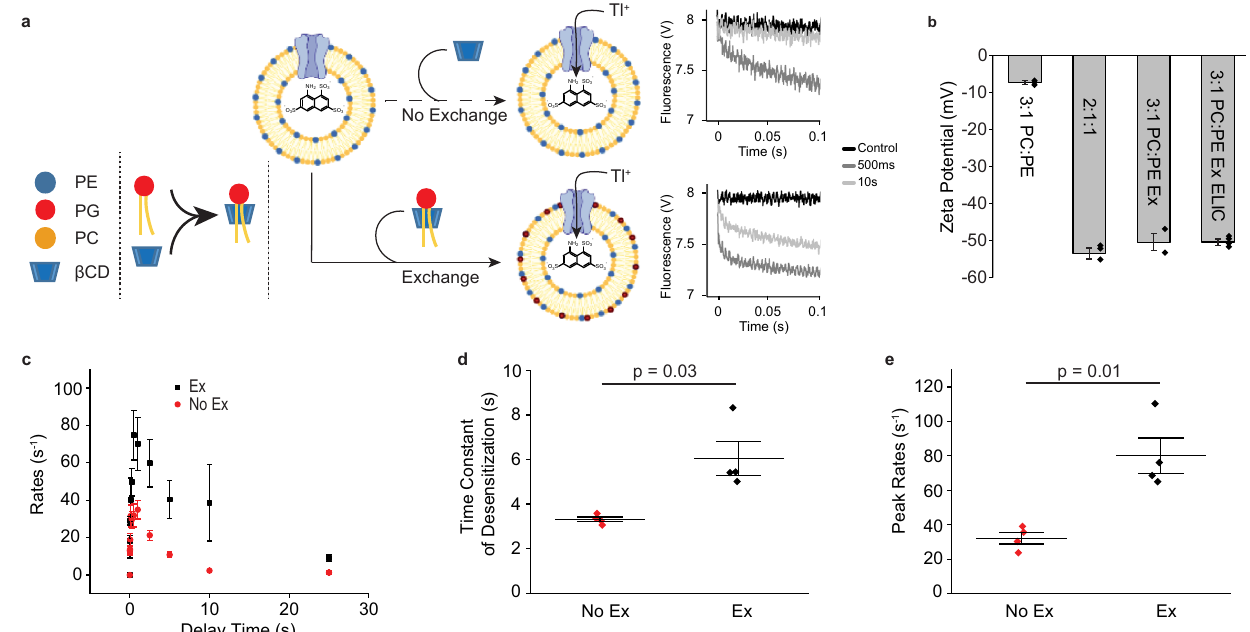
Fig. 4 | Asymmetric liposome stopped- fl ow Tl + fl ux assay. a Schematic repre- sentation of asymmetric liposome stopped- fl ow Tl + fl ux assay (created with BioR- ender.com). Starting with 3:1 POPC:POPE liposomes reconstituted with ELIC, the sample waseithertreatedwithm β CD(top, “ NoExchange ” ), ortreated withm β CD/ POPGtointroduce25mole%POPGtotheouterlea fl et(bottom, “ Exchange ” ). Right : Representative fl uorescencequenchingtracesfornoexchange(top)andexchange (bottom) samples showing control (no agonist) and responses to 10mM propyla- mine with 500ms and 10s delay times. b Zeta potential measurements of sym- metric 3:1 POPC:POPE liposomes (3:1 PC:PE) ( n =3), symmetric 2:1:1 POPC:POPE:POPG liposomes (2:1:1) ( n = 3), asymmetric 3:1 POPC:POPE liposomes treated to introduce 25mol% POPG to the outer lea fl et (3:1 PC:PE Ex) ( n = 2), and